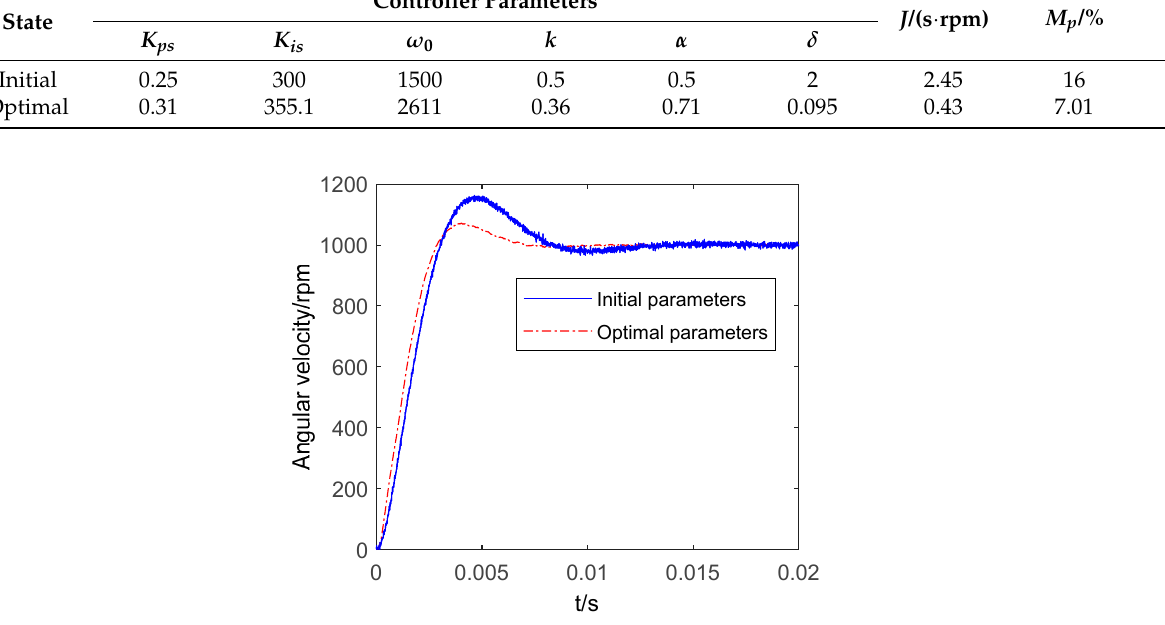
Figure 14. Step response comparison of 1000 rpm speed input.